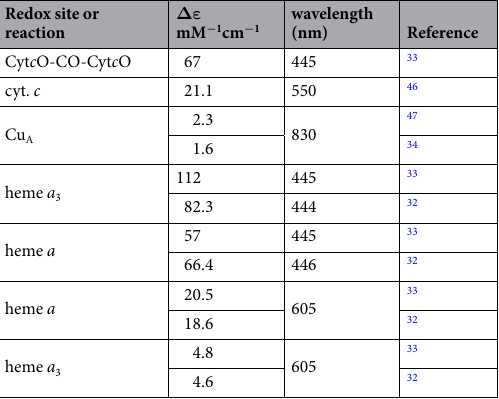
Table 1. Reduced minus oxidized difference absorption coefficients ( Δε ) of the redox sites, except the first line where the Δε is given for CO binding to the reduced heme a 3